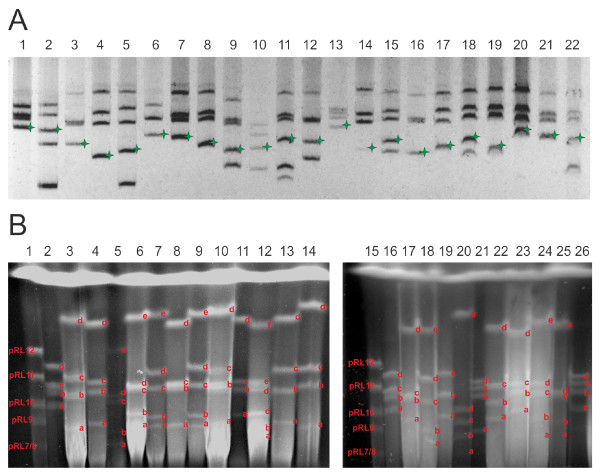
Plasmid profiles of selected R. leguminosarum bv. trifolii nodule isolates. (A) Profiles obtained in Eckhardt-type agarose gel electrophoresis; stars colored in green indicate pSym plasmids. Lanes: 1-RtTA1; 2-Rlv 3841; 3-K2.2; 4-K2.4; 5-K2.9; 6-K3.6; 7-K3.8; 8-K3.12; 9-K3.16; 10-K3.22; 11-K4.11; 12-K4.13; 13-K4.15; 14-K4.16; 15-K4.17; 16-K5.6; 17-K8.7; 18-K9.2; 19-K9.8; 20-K10.7; 21-K10.8, 22-K12.5 (B) PFGE separated replicons of Rlt nodule isolates further submitted to hybridization assays. The names of plasmids of Rlv 3841 strain, used as molecular weight markers were shown [6]. Molecular weight of Rlv 3841 plasmids is: 870, 684, 488, 353, 152, 147.5 kb. The letters on the respective bands of particular plasmids of individual strains indicates the plasmid name, e.g., "a" indicates pRlea plasmid. Lanes: 1-Rlv 3841; 2-RtTA1; 3-K2.4; 4-K3.12; 5-K3.16; 6-K4.13; 7-K4.17; 8-K5.6; 9-K9.2; 10-K10.4; 11-K3.8; 12-K4.11; 13-K8.7; 14-K9.8; 15-Rlv 3841; 16-RtTA1; 17-K2.2; 18-K2.9; 19-K3.6; 20-K3.22; 21-K5.4, 22-K10.7, 23-K10.8, 25-K3.13, 26-K4.15.